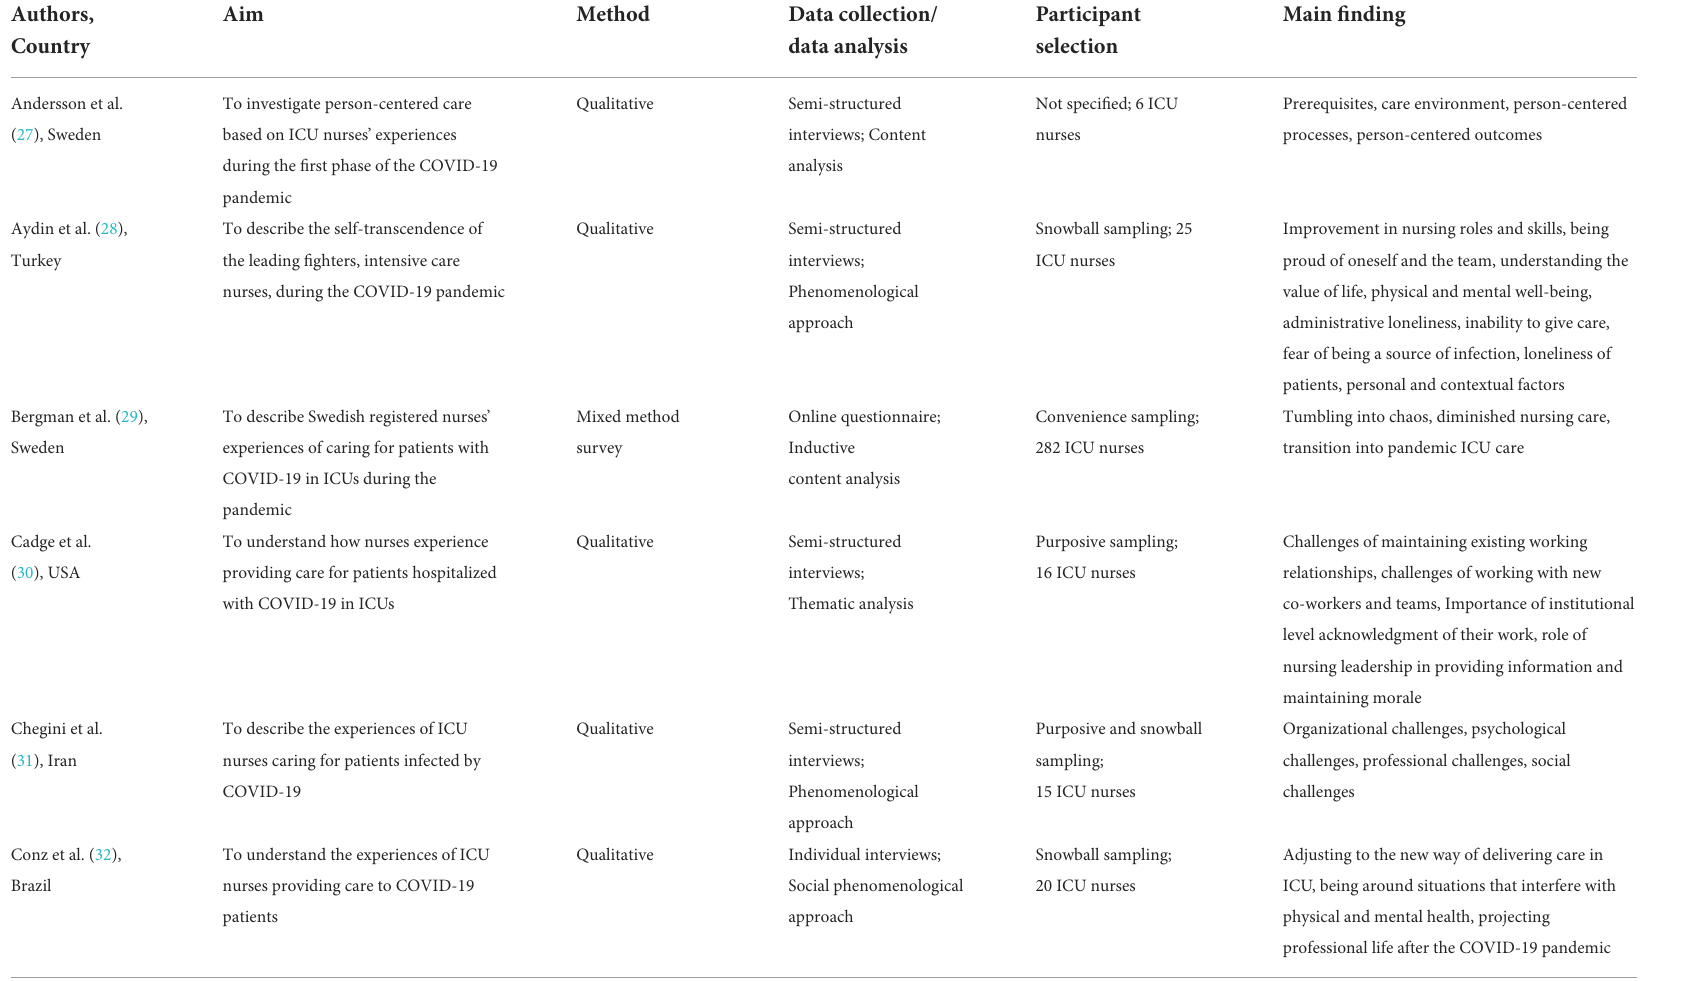
TABLE 2 Summary of characteristics of the studies selected for